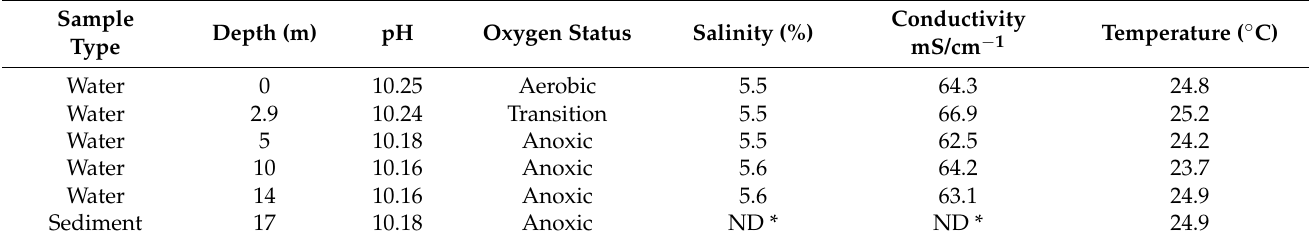
Table 1. Sample types and physicochemical measurement data from Lake